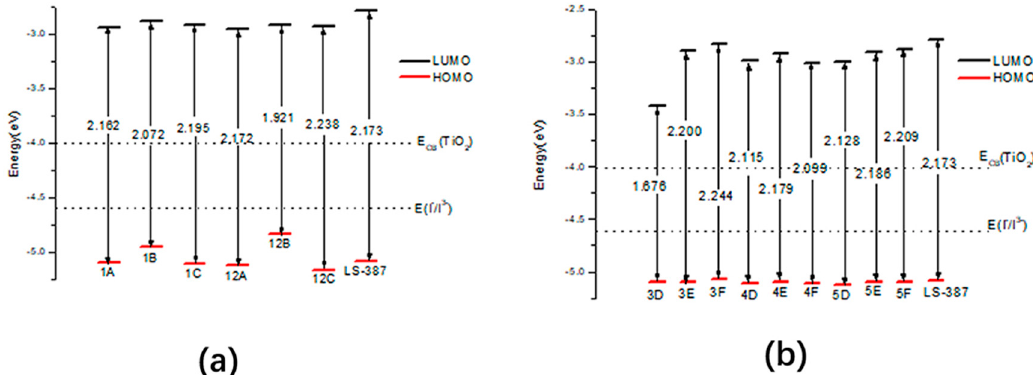
Figure 9. Energy level in solvent of LS-387-based designed molecules, where ( a ) is LS-387-X (X = 1A, 1B, 1C 12A, 12B and 12C), ( b ) is LS-387-Y (Y = 3D, 3E, 3F, 4D, 4E, 4F, 5D, 5E and 5F).